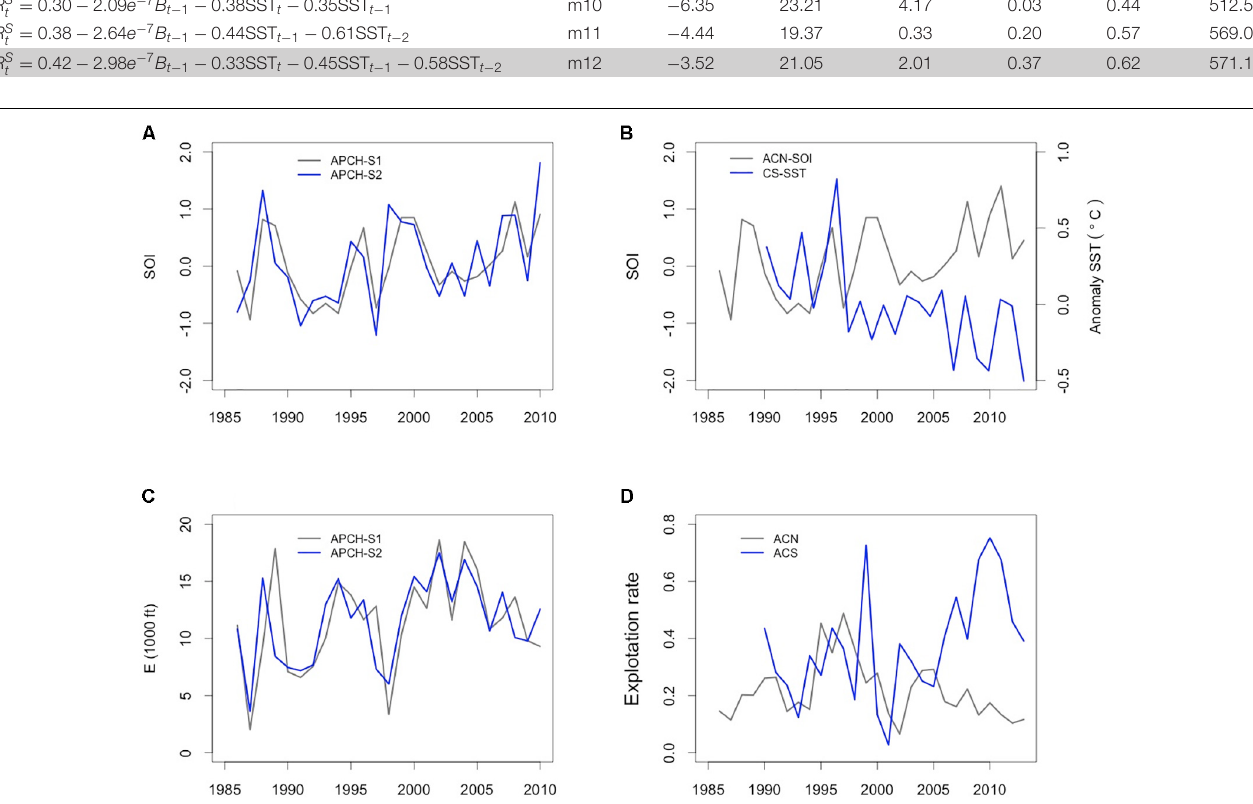
FIGURE 5 | Climate and fishing predictors of the anchovy and common sardine biomass dynamics off Chile. (A) Southern Oscillation Index (SOI) climate predictors for the anchovy population of southern Peru and northern Chile (APCH), (B) SOI for the anchovy population of central-northern Chile (ACN) and anomaly sea surface temperature (SST, ◦ C) for the common sardine, (C) fishing effort as the number of fishing trips (ft) ( y -axis has been/1000) for APCH. (D) Exploitation rates for the ACN and ACS populations.